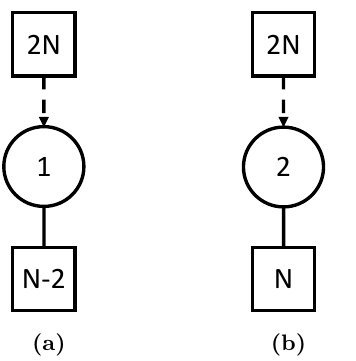
(cid:10) (cid:11) (cid:10) (cid:11) i ∗ T or T ∗ h T i . (b) The N = (0 , 4) quiver ∧ 2 V ∧ 2 V ∧ 2 V ∧ 2 V